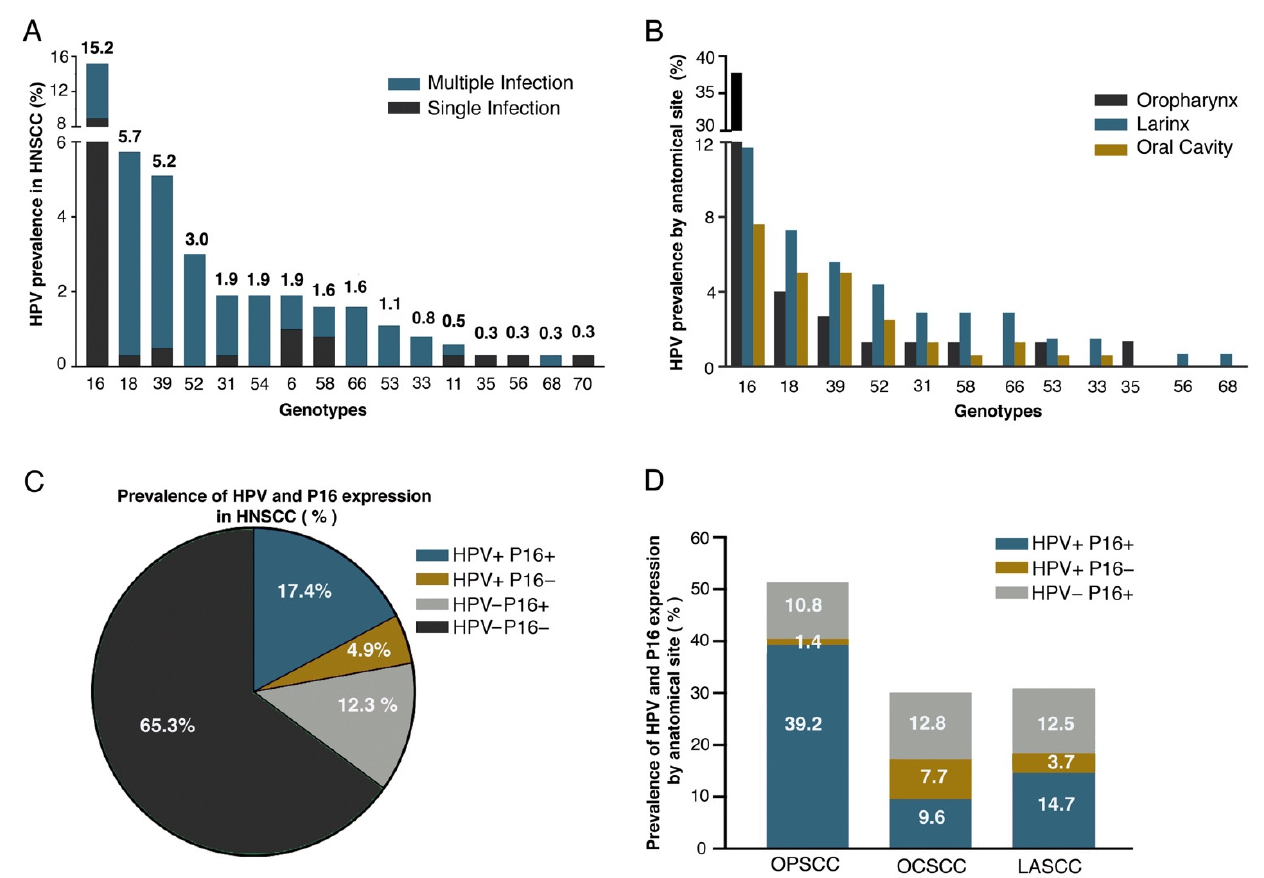
Figure 1. Prevalence of HPV and p16 in HNSCC. ( A ) Genotype prevalence in HNSCC. Cases found with each genotype are shown as single infection (SI) and multiple infections (MI); ( B ) distribution of most frequent high-risk genotypes per anatomical site; ( C ) prevalence of HNSCC according to HPV presence and p16 expression; ( D ) prevalence of HPV and p16 expression per anatomical site. Concordance in OPSCC was k = 0.75, in OCSS k = 0.36 and in LSCC k = 0.54, significance 0.000. Table 2. Distribution of cases HPV and p16 concordant and discordant and clinic variables associ-